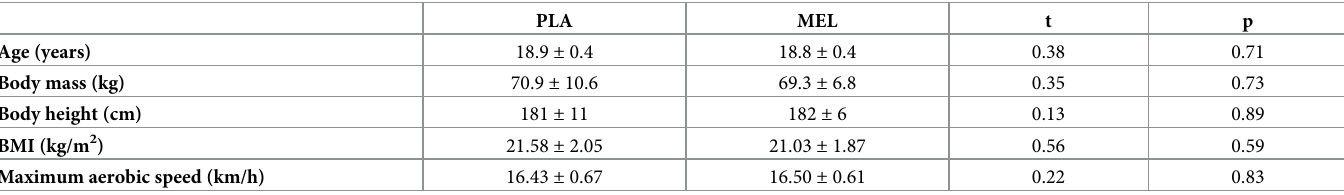
Table 1. Anthropometric and physical characteristics of melatonin (MEL) and placebo (PLA)